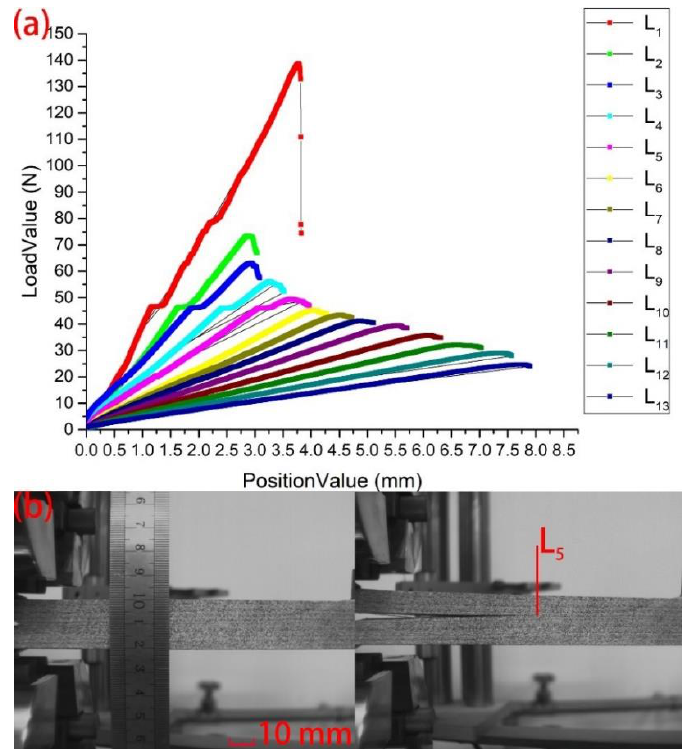
Figure 8. ( a ) The displacement load curve of Chinese fir test specimens, where “PositionValue” refers to the displacement. ( b ) Image calibration and crack monitoring.